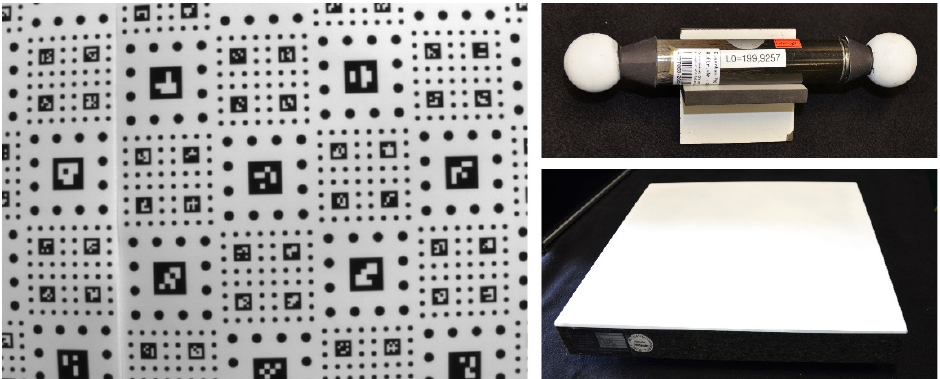
Figure 8. ArUco marker board (left) as primary calibration tool, and ball bar (upper right) and plane stone slab (lower right) for calibration refinement according to the ray ‐ based model.